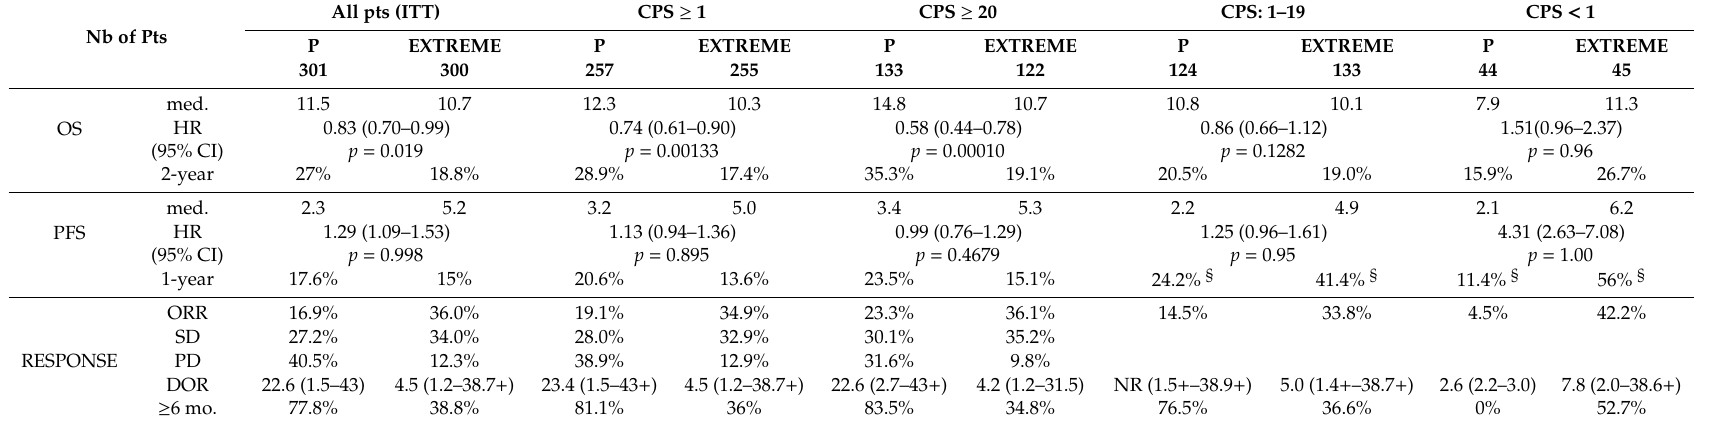
Table 3. KEYNOTE-048: Pembrolizumab vs. EXTREME according to CPS.